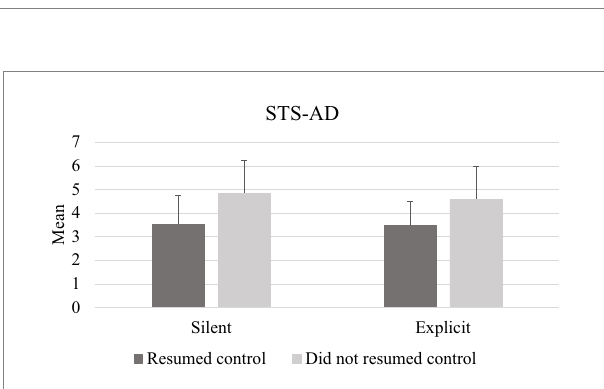
FIGURE 9 Mean scores for the STS-AD scales in both experimental conditions.